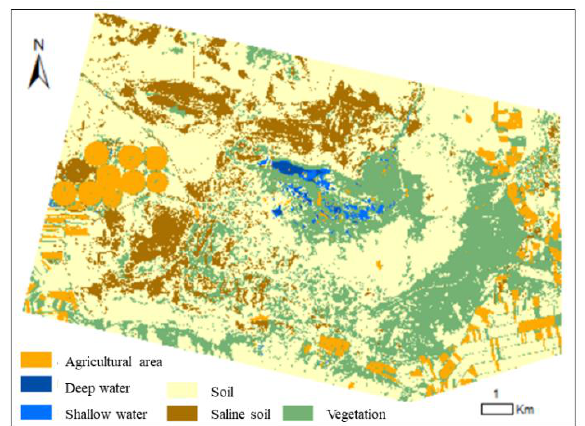
Figure 6. a) Thematic map produced from Worldview-3 with rule based classifier.